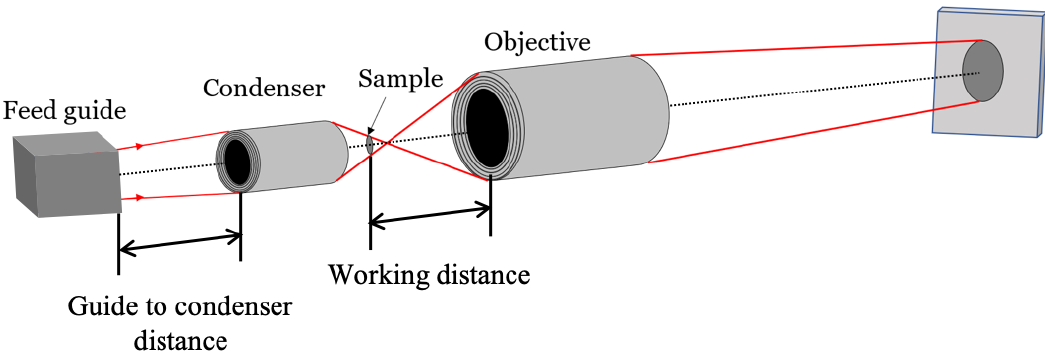
Figure 1. Schematic of a neutron microscope with a condenser and objective mirrors. Red lines trace edge rays through the system, and the dotted line is the optical axis. The sample-to-objective distance is commonly referred to as the working distance in a microscope.